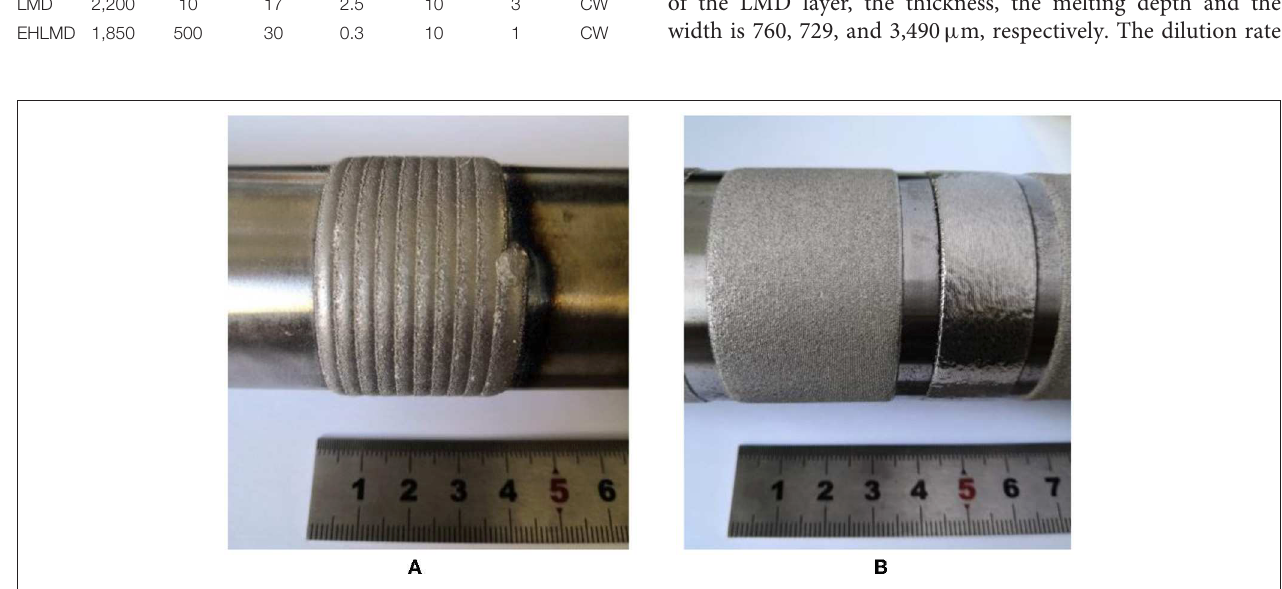
Frontiers in Materials |